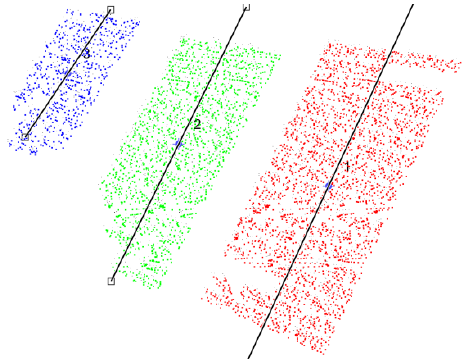
Figure 15. Principal component of each module for the first case using a down-sampling of 1:160 .